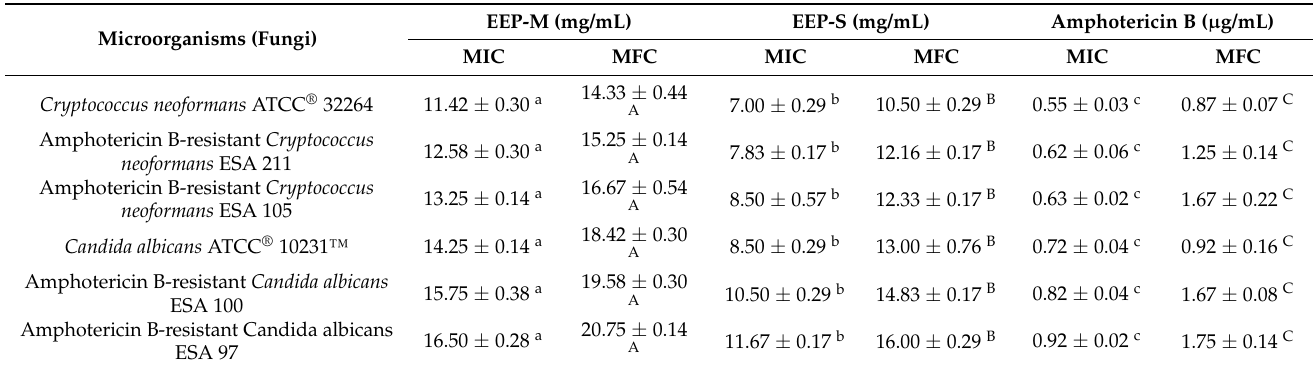
Values are expressed as mean ± SEM. N = 3 experiment per group. Different letters represent statistical differences between groups ( p < 0.05): lowercase letters for MIC and uppercase letters for MBC. Table 4. Minimum inhibitory concentration (MIC) and minimum fungicidal concentration (MFC) for the studied